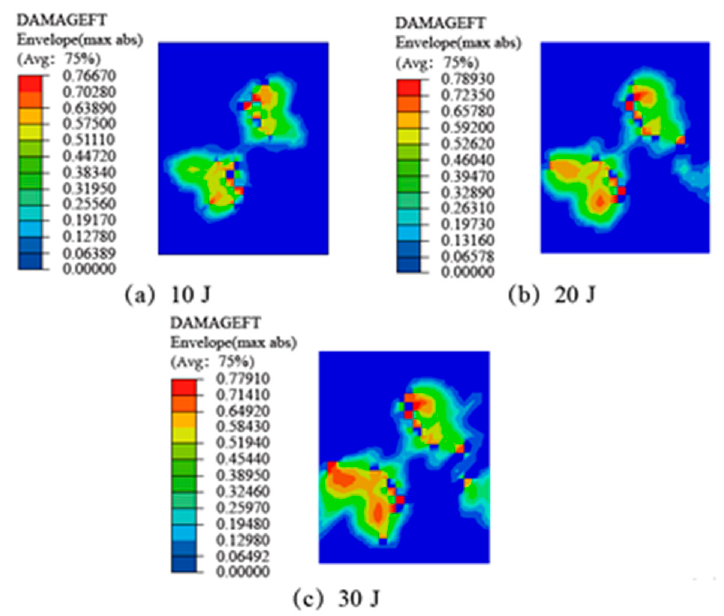
Figure 10. The fiber tensile damage of CFRP laminate SLJs at different impact energies: ( a ) 10 J; ( b ) 20 J; ( c ) 30 J.